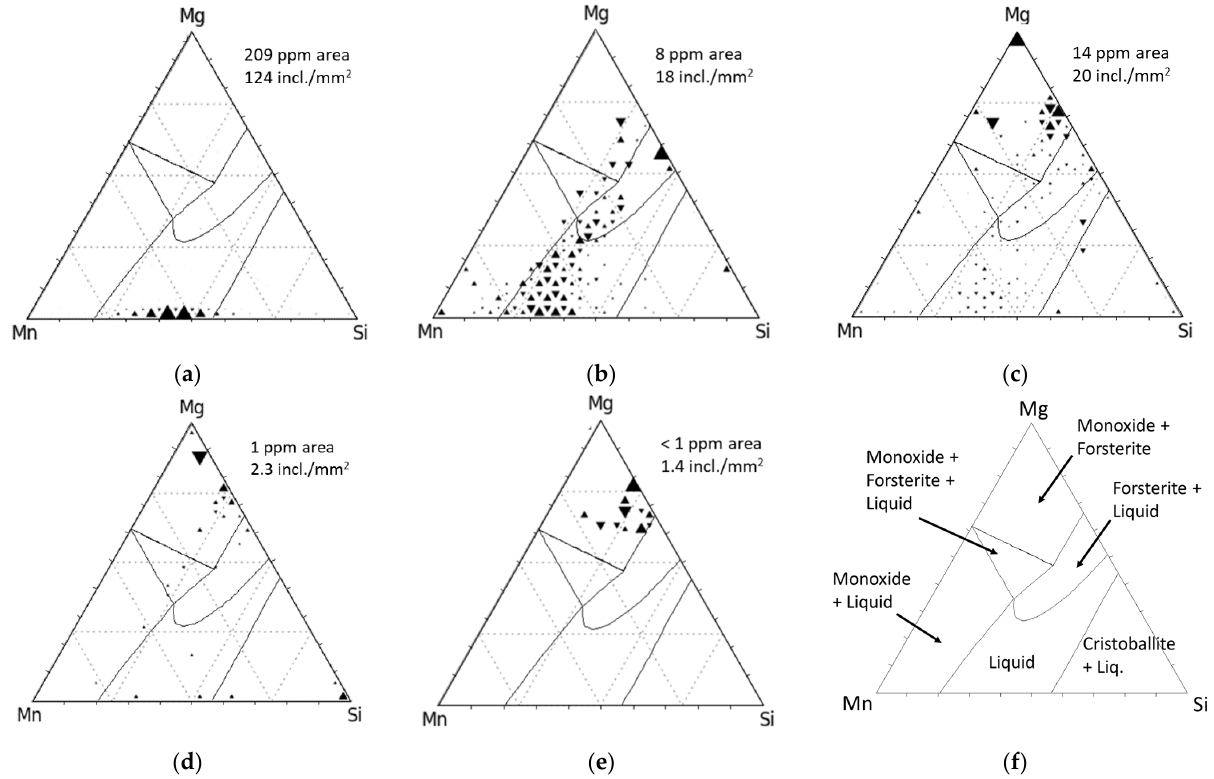
Figure 3. Ternary diagrams showing nonmetallic inclusion evolution during a steel–slag reaction. Inclusion compositions (as analyzed by SEM/EDS) are plotted as mole fractions of MnO, SiO 2 , and MgO. Each ternary represents a sample taken at different times: ( a ) immediately before slag addition, and ( b ) 800 s, ( c ) 1,580 s, ( d ) 3,080 s, and ( e ) 4,540 s after slag addition. The triangles are proportional to the area fraction of that nonmetallic inclusion composition. Ternary ( f ) is the isothermal section of MnO-SiO 2 -MgO at 1,600 °C (calculated using FactSage 8.0).